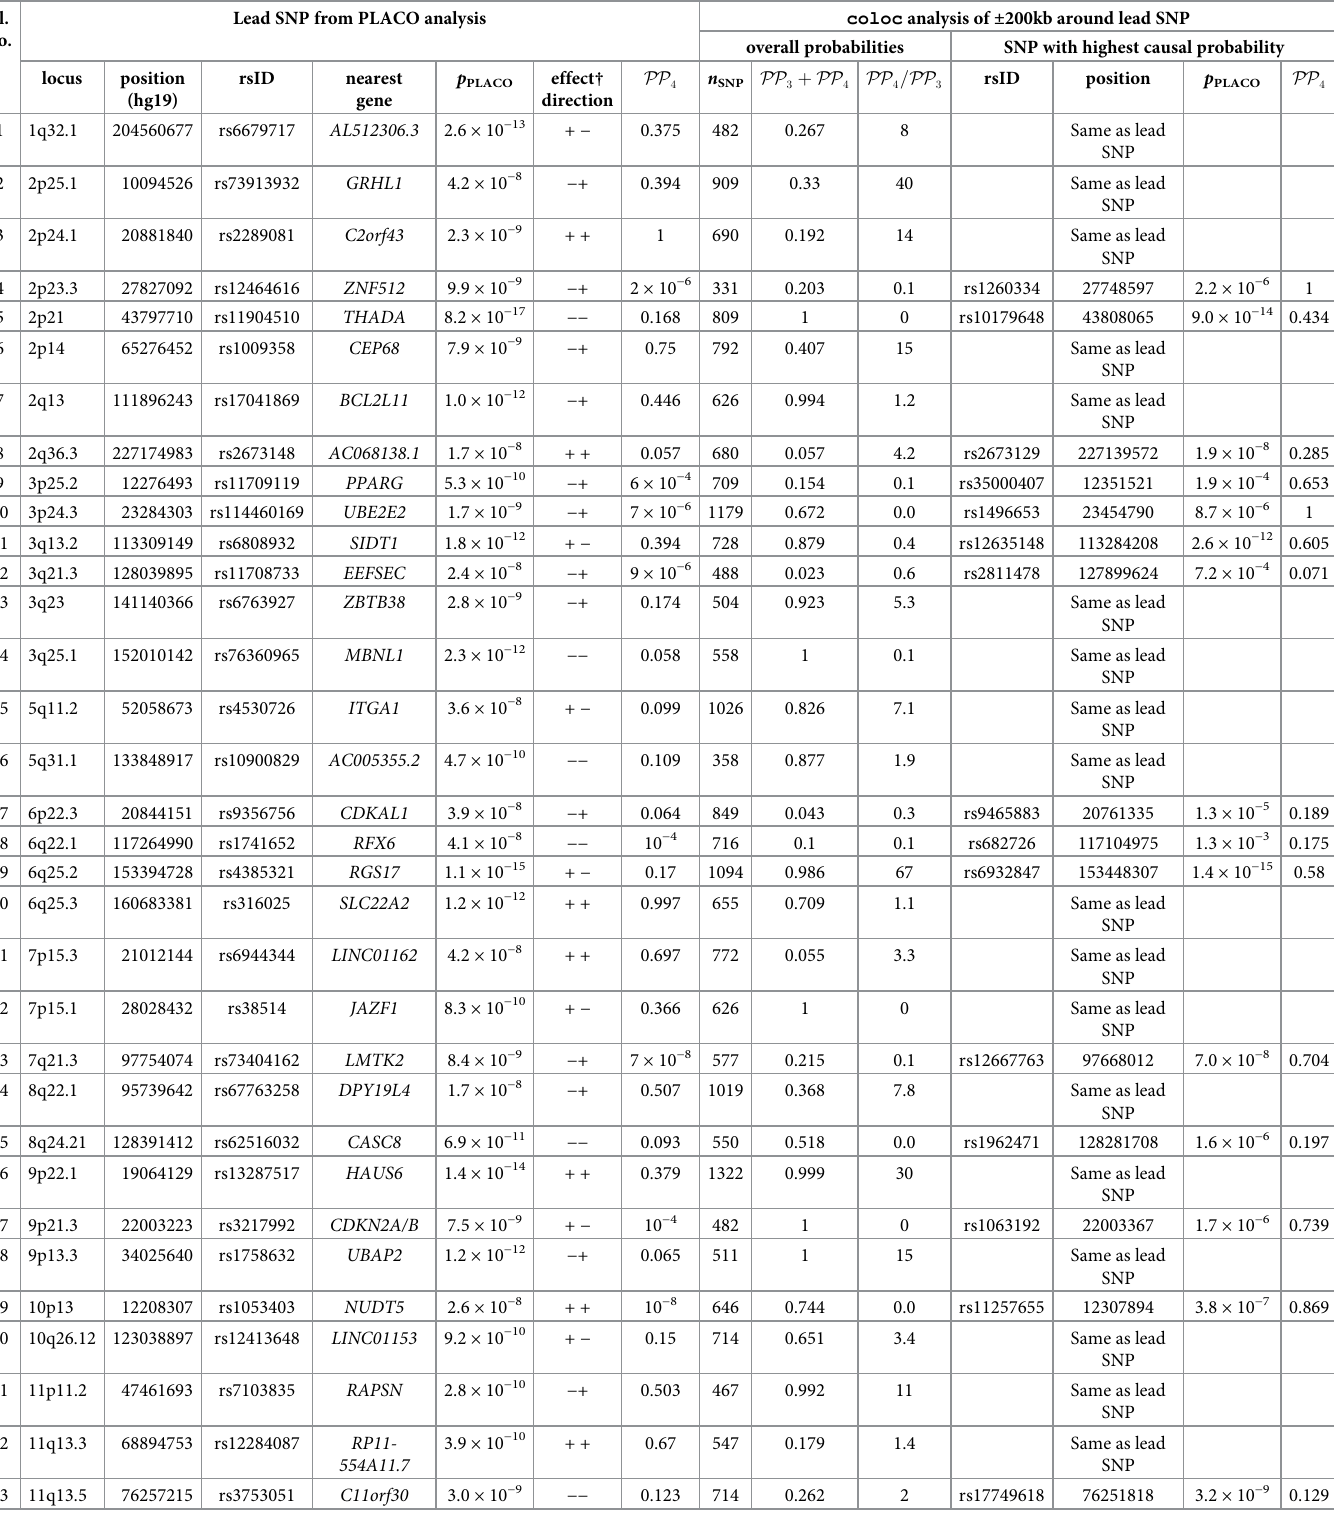
) for the lead SNPs from each of the 43 pleiotropic loci identified by PLACO. 4